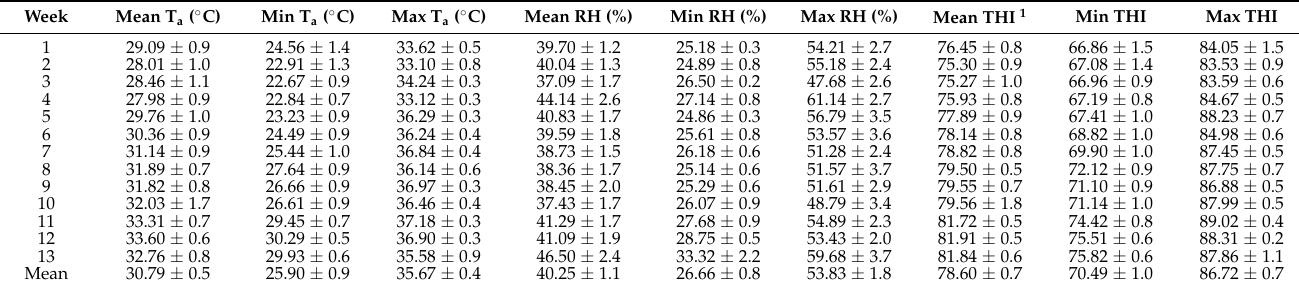
Table 2. Ambient temperature (Ta), relative humidity (RH), and calculated temperature humidity index (THI) 1 registered every hour and expressed as a weekly